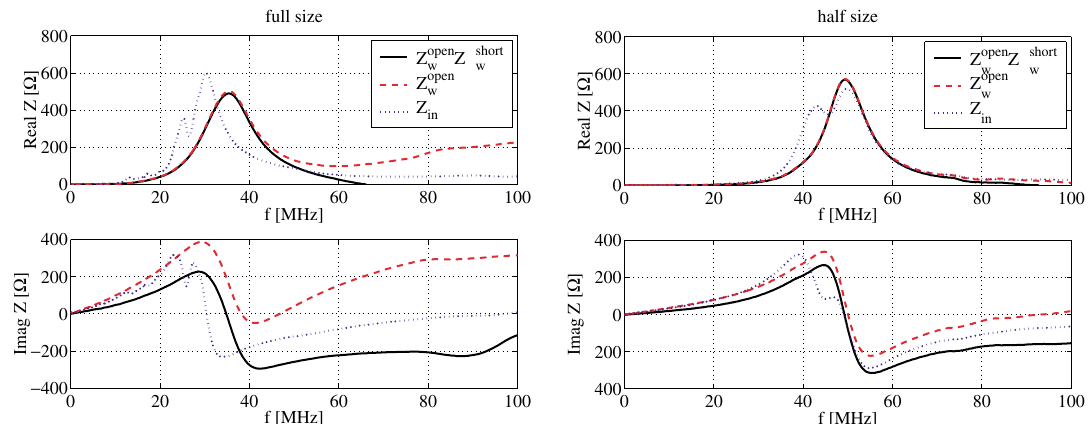
FIG. 10. (Color) Comparison of the input impedance at the busbar and the scaled measured impedance. Full-size model (left panel) and half-size model (right panel).